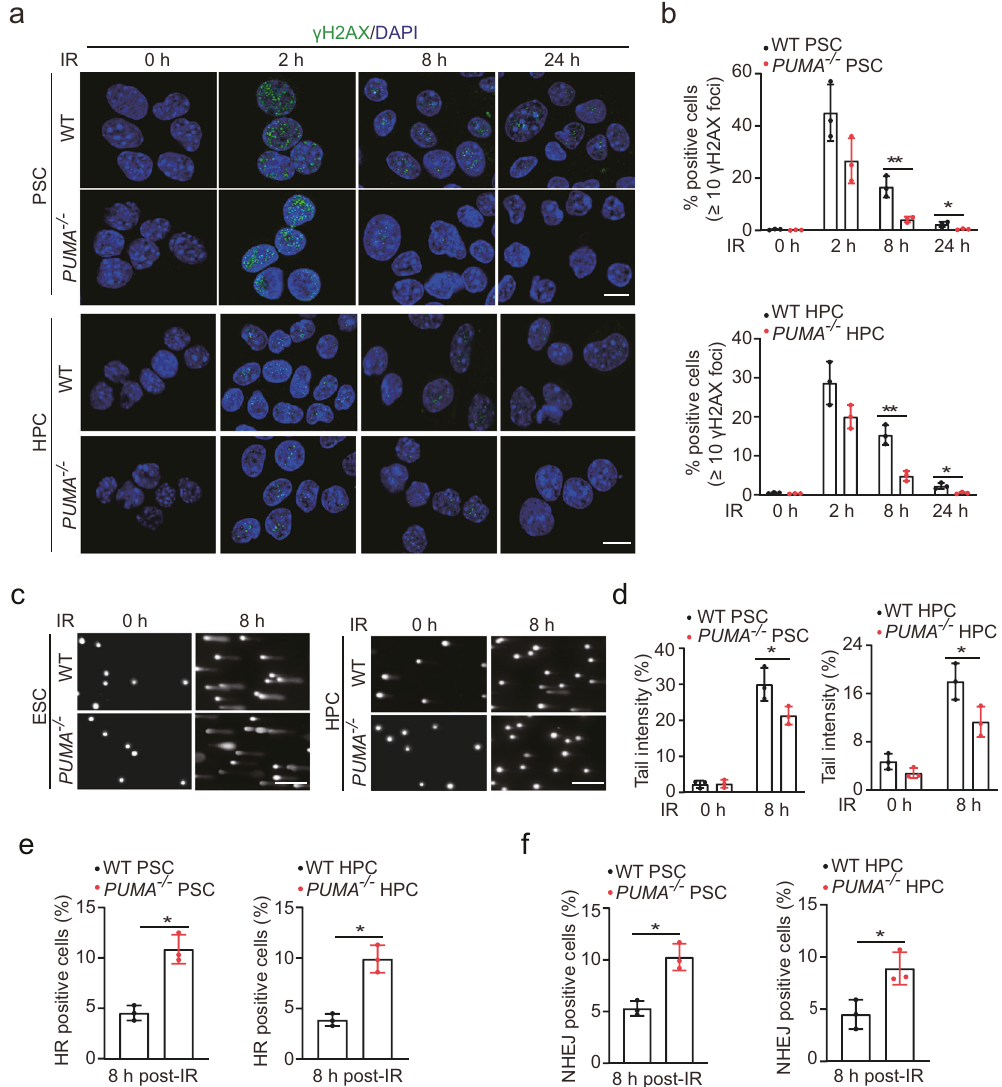
Fig. 1 Knockout of PUMA enhances IR-induced DNA repair in PSCs and HPCs. a Representative images of γ H2AX foci in PUMA wild type (WT) and KO PSCs and HPCs after IR. Scale bars, 10 μ m. PSCs and HPCs were treated with 2 Gy IR and then fi xed at 0, 2, 8, or 24 h for γ H2AX staining. b Quanti fi cation of γ H2AX foci in a . The percentage of positive cells ( ≥ 10 γ H2AX foci) is shown. c Representative images of comet tails in PUMA WT and KO PSCs or HPCs at indicated time points after treated with 2 Gy of IR. Scale bars, 250 μ m. d Quanti fi cation of comet tail intensity in c . e , f Quanti fi cation of HR ( e ) or NHEJ ( f )-positive cells in PUMA WT and KO PSCs or HPCs. At 48 h after I- Sce I transfection, PUMA WT or KO PSC and HPC cells with stable expression of a pDR-GFP or pEJ5-GFP reporter were treated with 2 Gy IR and then harvested at 8 h for analysis, using fl ow cytometry to examine recombination induced by I- Sce I digestion. Dead cells were excluded by PI staining. Data are representative of three independent experiments with similar results. Error bars, SD. * P < 0.05, ** P <